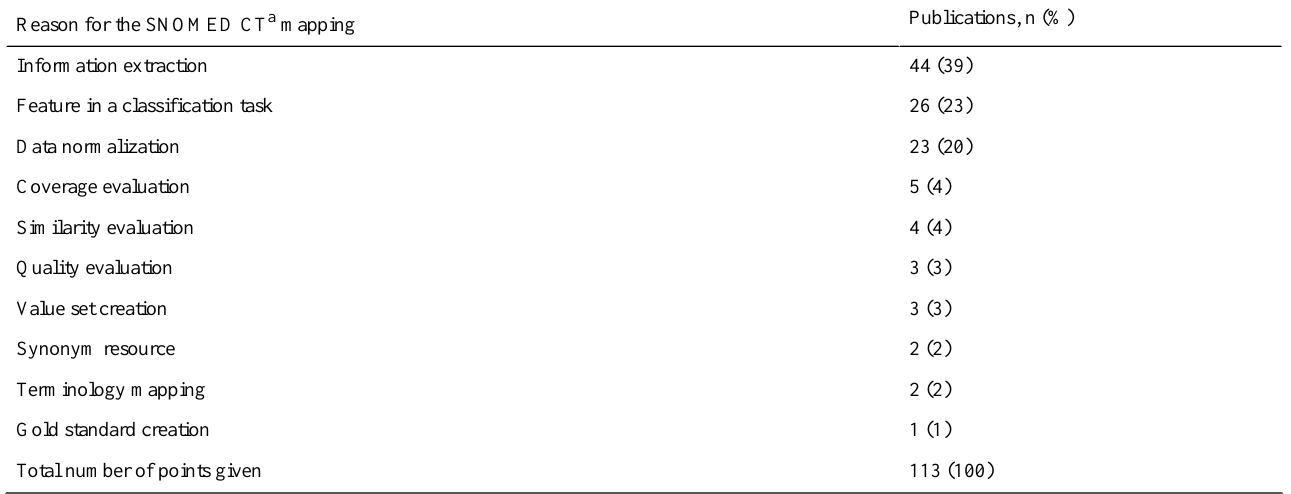
Table 5. Reason for the mapping in publications.